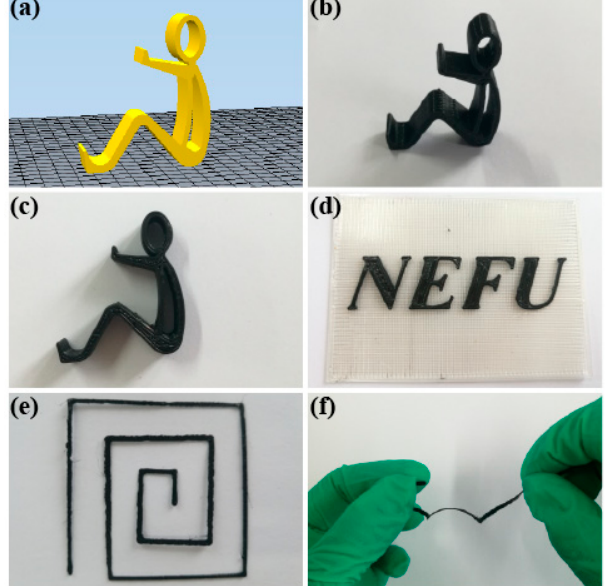
Figure 13. Different models printed by fused deposition modeling (FDM): the human-shaped phone stand holder from blueprint to the finished product ( a – c ), NEFU (the abbreviation of Northeast Forestry University) printed on the PLA baseplate ( d ), the printed circuit ( e ), and its stretched part ( f ).